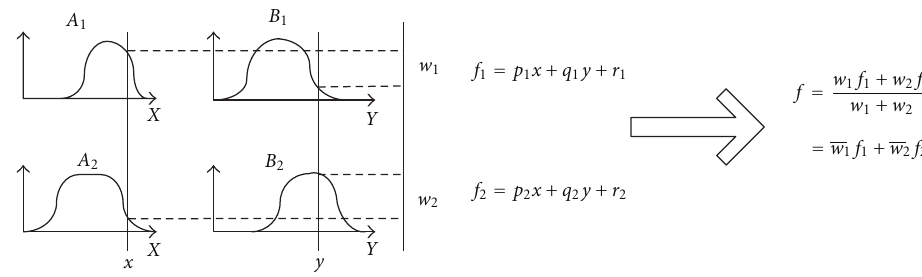
Figure 3: A two-input first-order Sugeno fuzzy model with two rules.